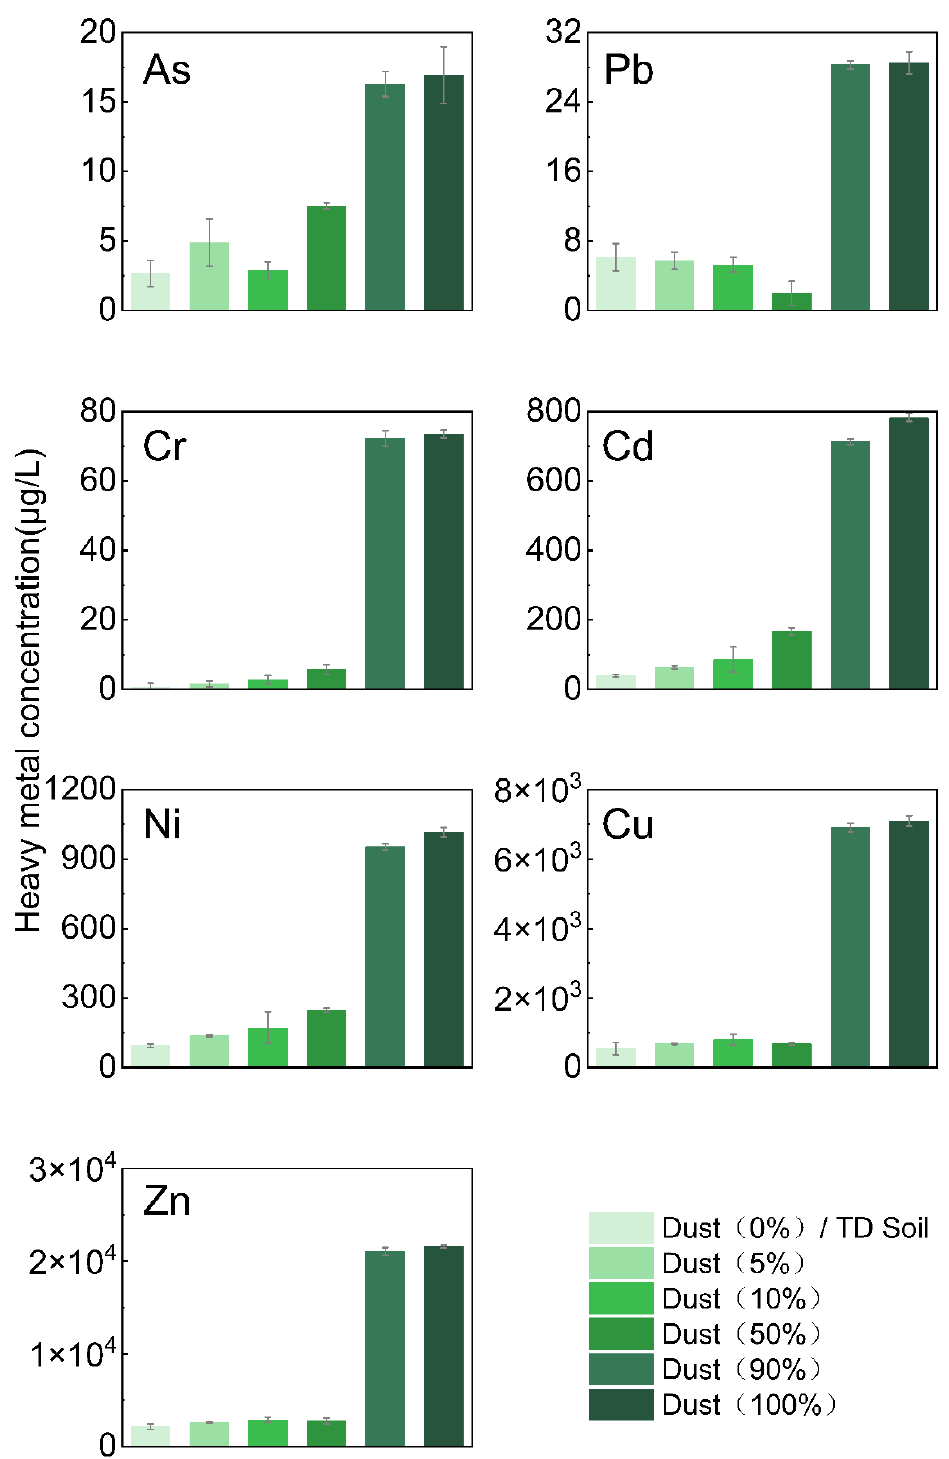
Figure 3. Leaching concentrations of seven heavy metals, determined by TCLP. The mass ratios of dust to the total mixed sample were 0%. 5%; 10%; 50%; 90%; and 100%. The leaching